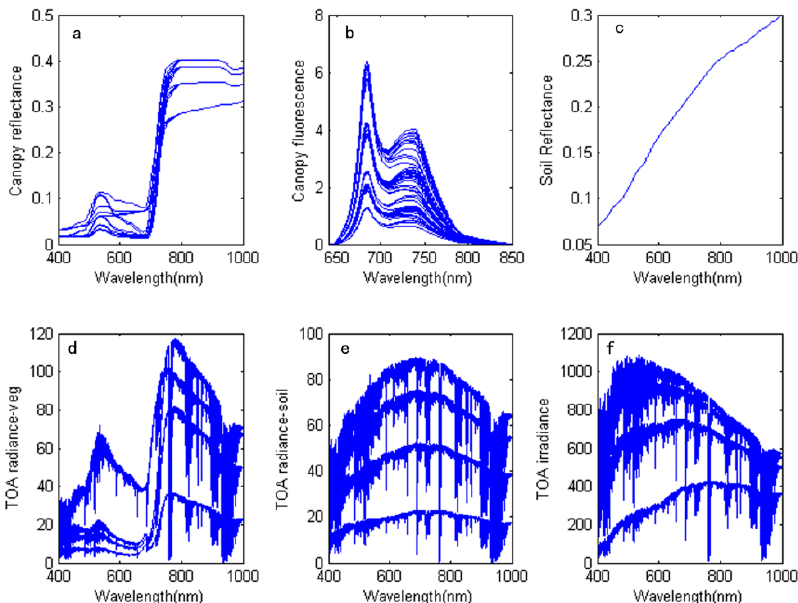
Figure 1. Input spectrum and the simulated results: ( a ) Canopy reflectance spectrum from SCOPE; ( b ) Canopy fluorescence spectrum from SCOPE (W/m 2 /µm/sr); ( c ) Soil reflectance spectrum from the library of ENVI; ( d ) Simulated vegetation TOA radiance (W/m 2 /µm/sr); ( e ) Simulated soil TOA radiance (W/m 2 /µm/sr); and ( f ) Solar irradiance (W/m 2 ).